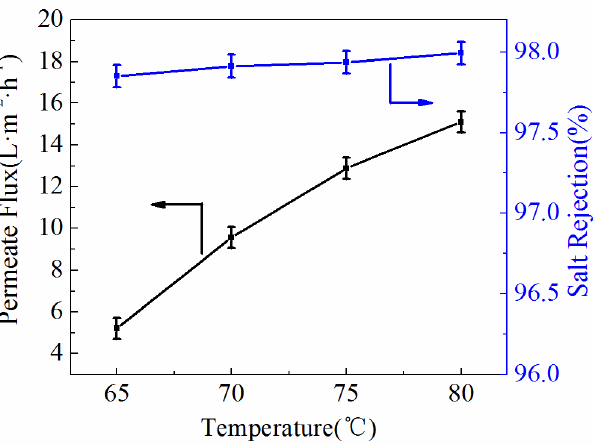
Figure 11. Effect of feed temperature on the permeate flux and salt rejection (NaCl concentration, 3.5 wt.%; Vacuum pressure, 0.07 MPa).